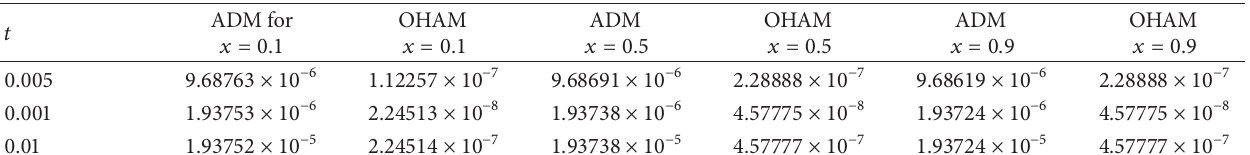
Table 5: Comparison of absolute errors obtained by OHAM and ADM [5] for 𝛼 = 0.001 , 𝛽 = 0.001 , and 𝛿 = 1